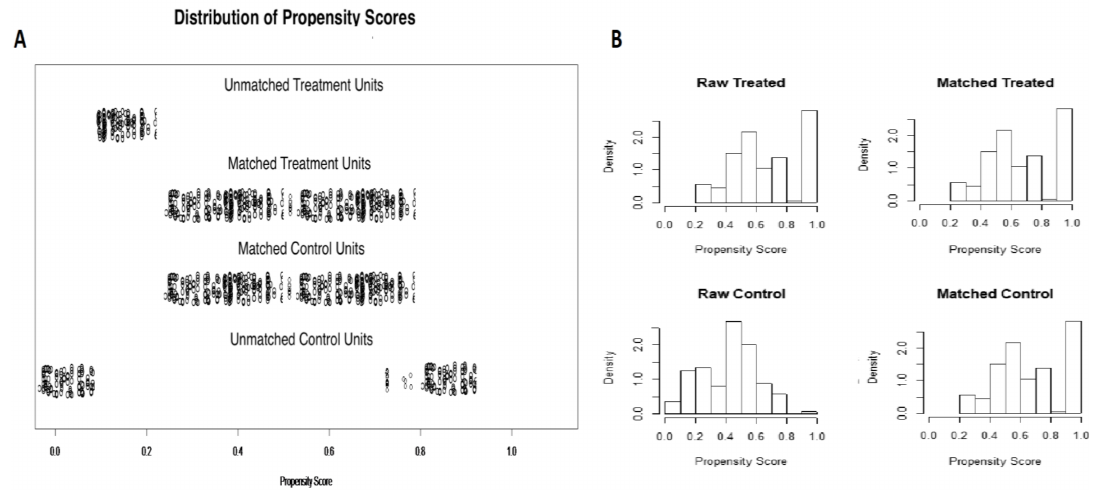
Figure 1. Propensity score matching. Out of the initial 832 patients, after 1-to-1 propensity score caliper matching, 610 patients were selected for comparison: 305 patients treated with non-anesthetist-administered propofol sedation and 305 controls (with anesthesia specialist-administered propofol sedation). ( A ) Propensity score matching jitter plot; ( B ) propensity score matching histogram.